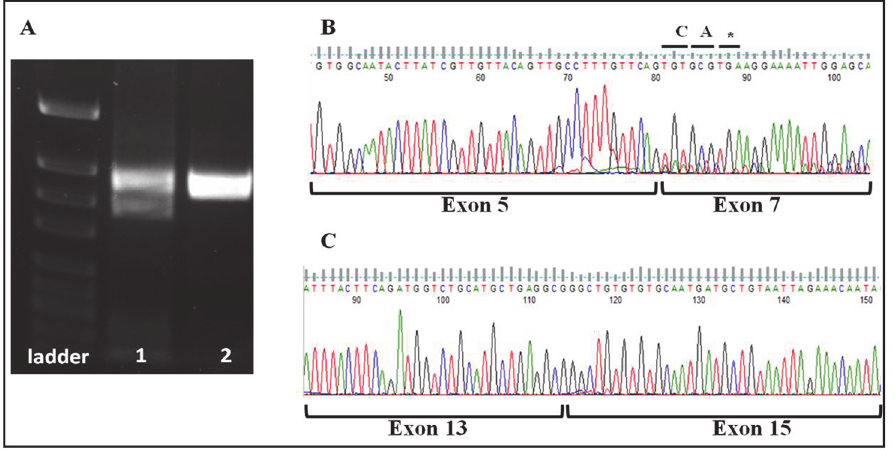
Fig 1. Analysis of the acceptor splice-site mutation and the missense mutation. (A) Agarose gel electrophoresis of cDNA amplified from the patient with r.313 – 1G > A (lane 1) and cDNA of normal individual (lane 2). The first lane reveals two bands indicating expression from two alleles; the normal (upper band) and the mutant (lower band). (B) cDNA sequence of patient with r.313 – 1G > A revealing skipping of exon 6, and resulting in a premature stop codon. (C) cDNA sequence of patient with (c.1372G > C) mutation revealing the skipping of exon